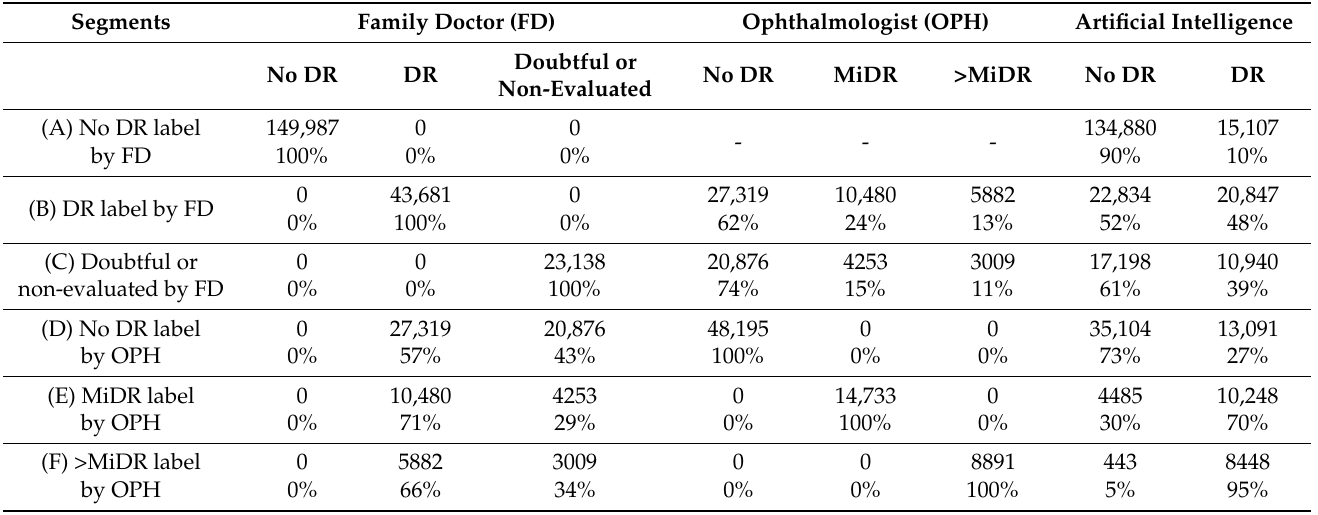
Table 1. Evaluation by family doctors (FD), ophthalmologists (OPH) and artificial intelligence over